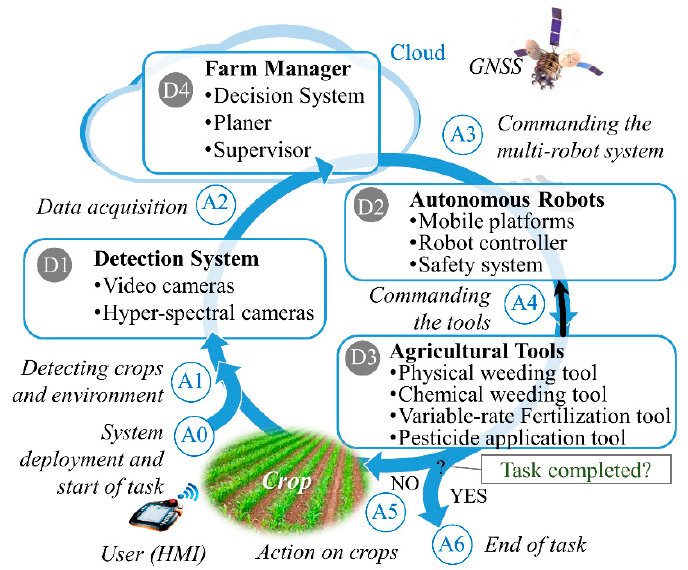
Figure 8. Components of a precision agriculture robotic system.